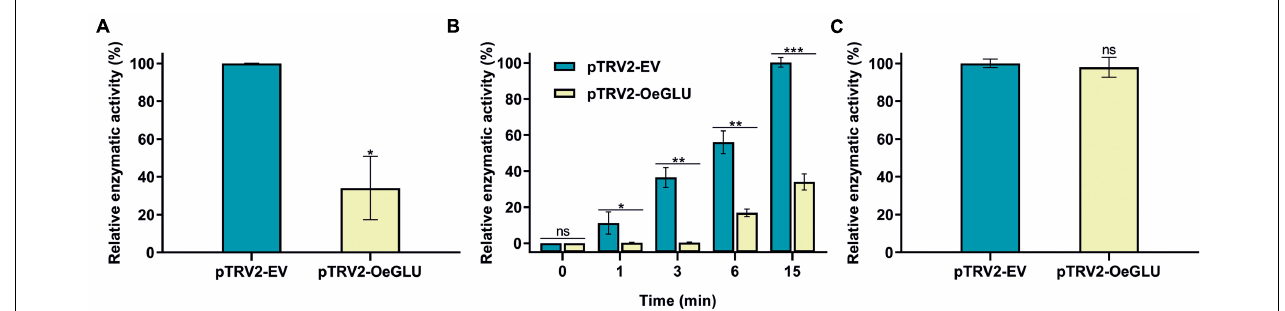
FIGURE 3 | In vitro enzymatic assays of crude leaf protein extracts of olives Agroinoculated with either pTRV2-EV or pTRV2-OeGLU constructs. (A) Relative enzymatic activity against oleuropein at 6 min. (B) Relative enzymatic activity against oleuropein at regular time intervals. (C) Relative enzymatic activity against pNPGlu. Three technical replicates of three biological replicates per treatment were analyzed. Mean ± SE and asterisks denote statistical significance (*** P ≤ 0.001, ** P ≤ 0.01, * P ≤ 0.05, ns: not significant; Student’s t -test). EV, empty vector; OeGLU, oleuropein β -glucosidase; pNPGlu, p -nitrophenyl β -D-glucopyranoside.